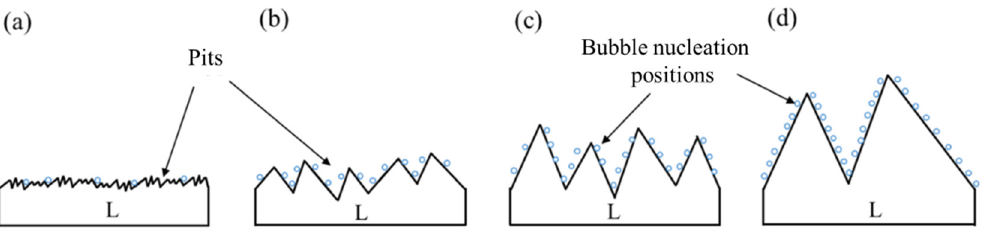
Figure 11. Effect of roughness (( a ) < ( b ) < ( c ) < ( d )) on density at bubble nucleation position.